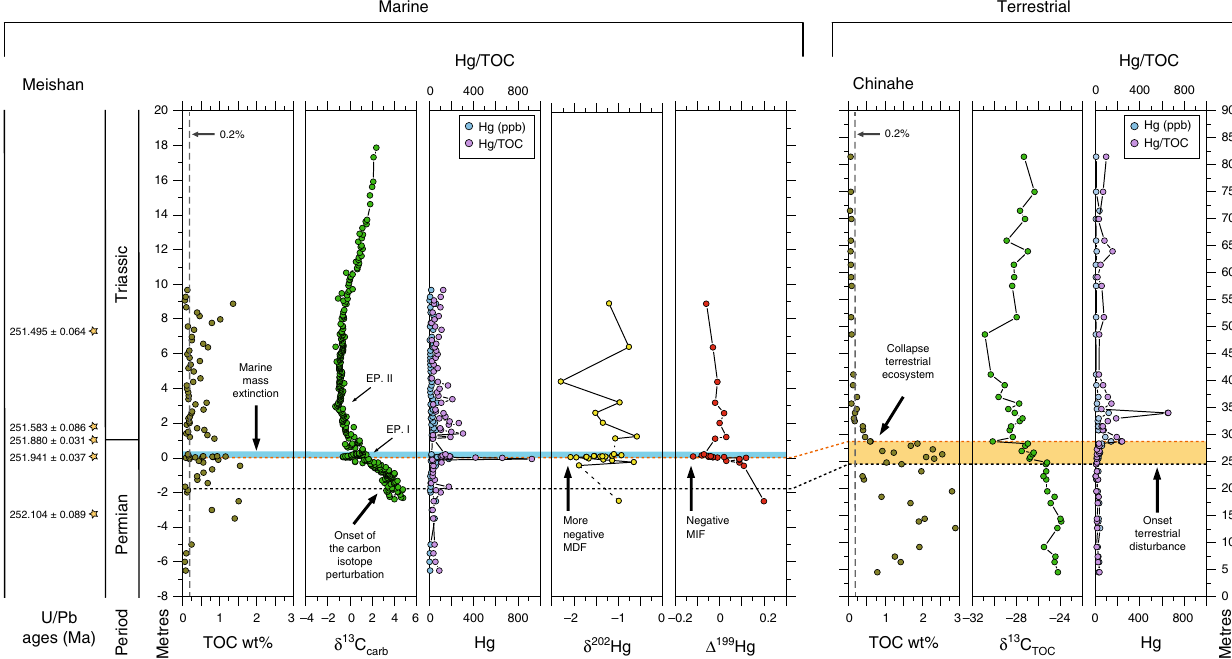
Fig. 1 Permian – Triassic events. Existing records show the terrestrial extinction started before, and its collapse culminated at, the marine extinction interval, where large Hg and Hg/TOC spikes, negative δ 202 Hg, negative Δ 199 Hg and more negative δ 13 C values (EP. I 30 ) are recorded. After this event, the δ 13 C record shows a second minimum (Ep. II), while Hg concentration decreases, but remains relatively higher than background values, and δ 202 Hg and Δ 199 Hg rebound towards more positive values. This pattern is seen in many P – T successions, in terrestrial and shallow- to deep-water settings. Meishan section: U- Pb ages from Burgess et al. 34 ; TOC and C isotopes ( δ 13 C) from Xie et al. 30 ; Hg concentrations, δ 202 Hg and Δ 199 Hg data are from Grasby et al. 23 and Wang et al. 20 . Chinahe section: all data and correlation to Meishan section are from Chu et al. 14 . Note that to plot Hg (ppb) and Hg/TOC data, the same scale is used. MDF mass-dependent fractionation, MIF mass-independent fractionation, EP.